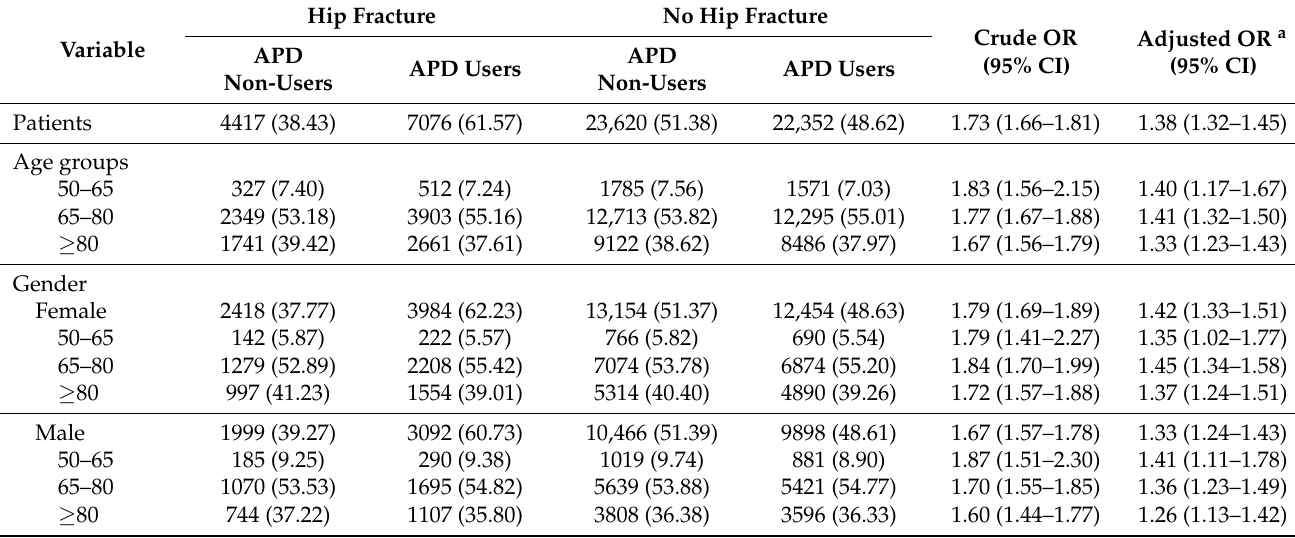
Table 2. The risk of hip fracture in patients with and without antipsychotic drug exposure, stratified by age and sex.